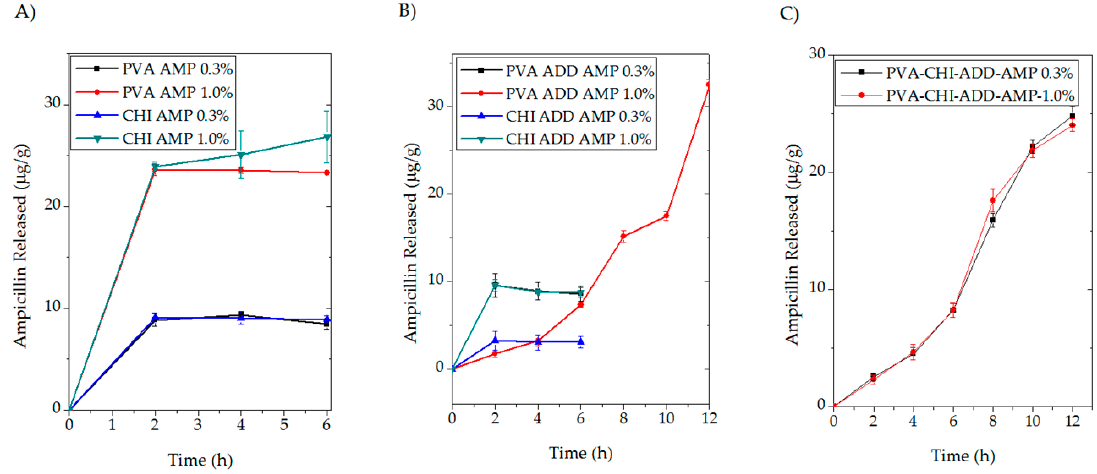
Figure 6. Release profile of AMP from BAPS measured by UV-VIS spectrophotometer.